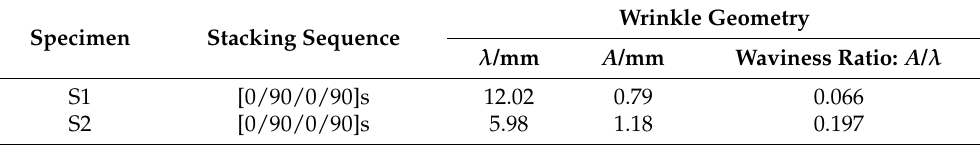
Figure 10. Morphology of wrinkles.